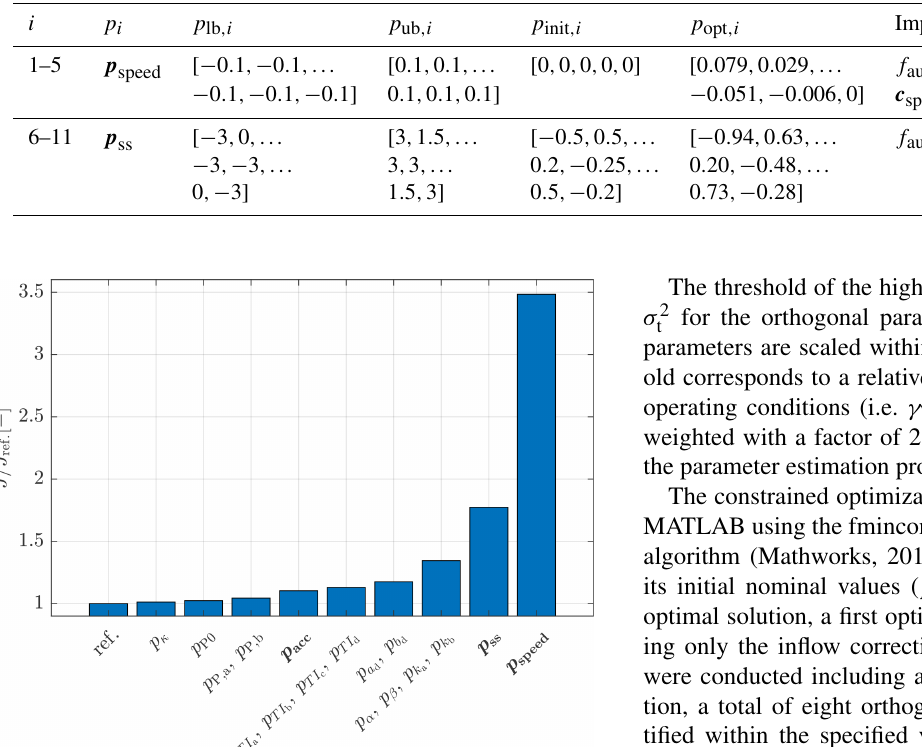
Table 2. Definition of the parameters, together with their initial values, lower and upper bounds, and identified values.